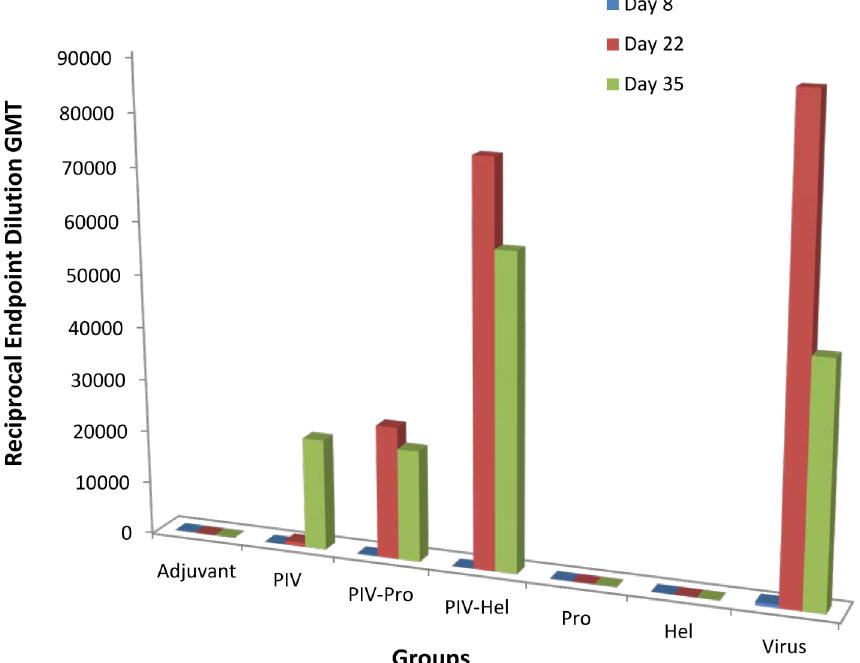
Fig 3. Serum IgG antibody responses. Anti-DENV-2 antibody responses in immunized mice measured by ELISA using purified virions. Bars indicate reciprocal geometric mean endpoint titers (GMT) (cid:2) 0.1 OD 405 . For calculation purposes titers < 100 were assigned a value of 5. PIV = purified inactivated vaccine, Pro = protease, Hel = helicase.